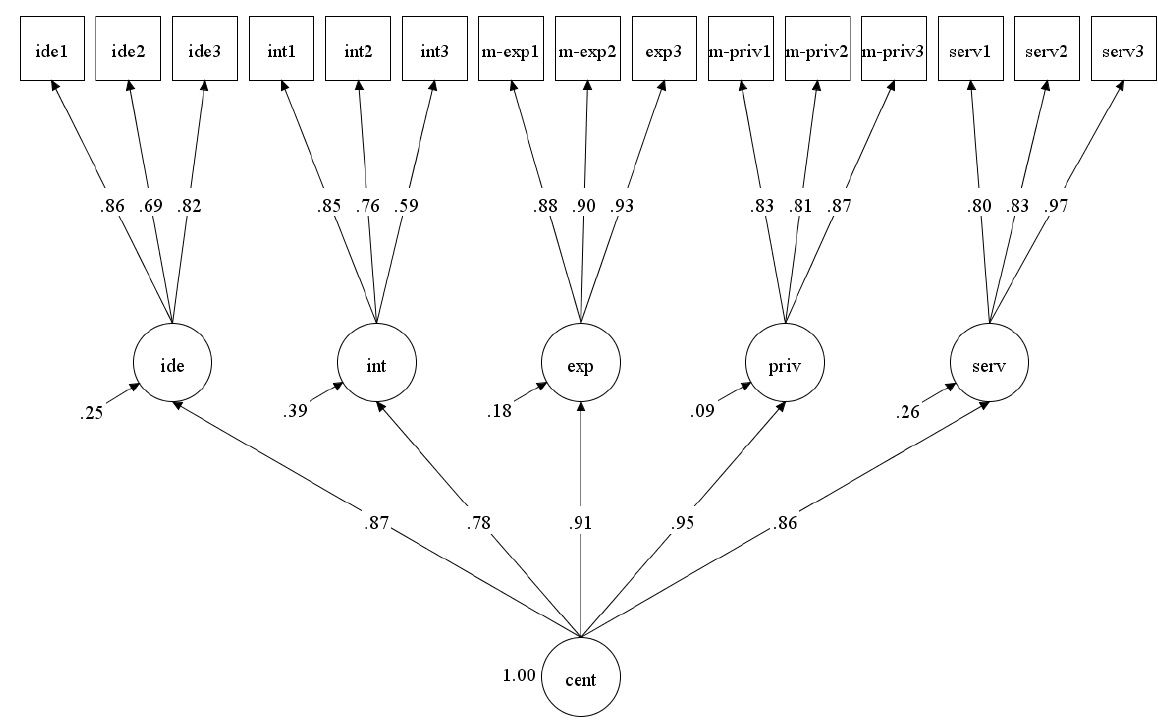
Figure A8. Results of the confirmatory factor analysis of the CRSi-20. Numbers in the plot represent standardized estimates. Cent = centrality of religiosity; int = intellect; ide = ideology; serv = public practice; priv = private practice; exp = experience; m = this prefix means that out of two items, only the one with the higher value for this core dimension is processed in the analysis. The number after the item name indicates the position of the item within the core dimension items. Squares depict manifest and circles latent variables. Residual arrows are not shown for the manifest variables. Numbers on arrows are factor loadings. The model is identified by setting the variance of the second level latent variable “cent” and the factor loading of each item with the suffix “1” to be equal 1. All reported estimates are significant at least α ≤ 0.05